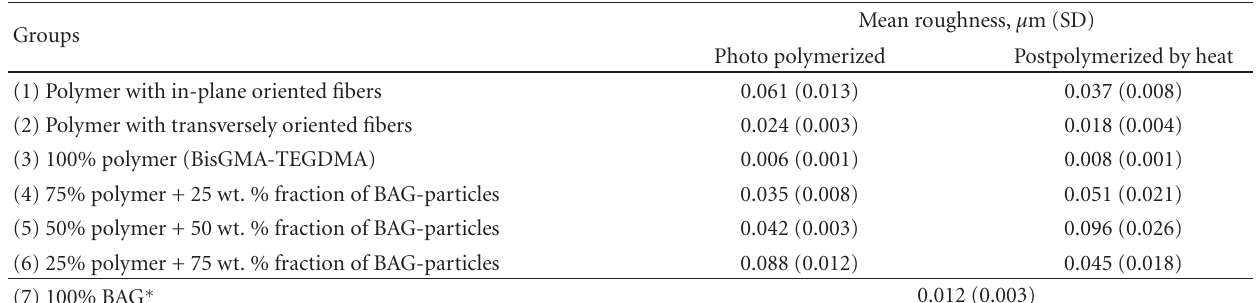
Table 3: Mean values and standard deviations (SD) of the specimens’ surface roughness recorded with a confocal image profiler. Groups